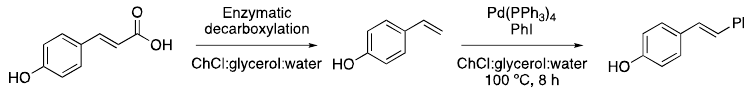
Figure 25. One-pot decarboxylation and Heck cross-coupling.